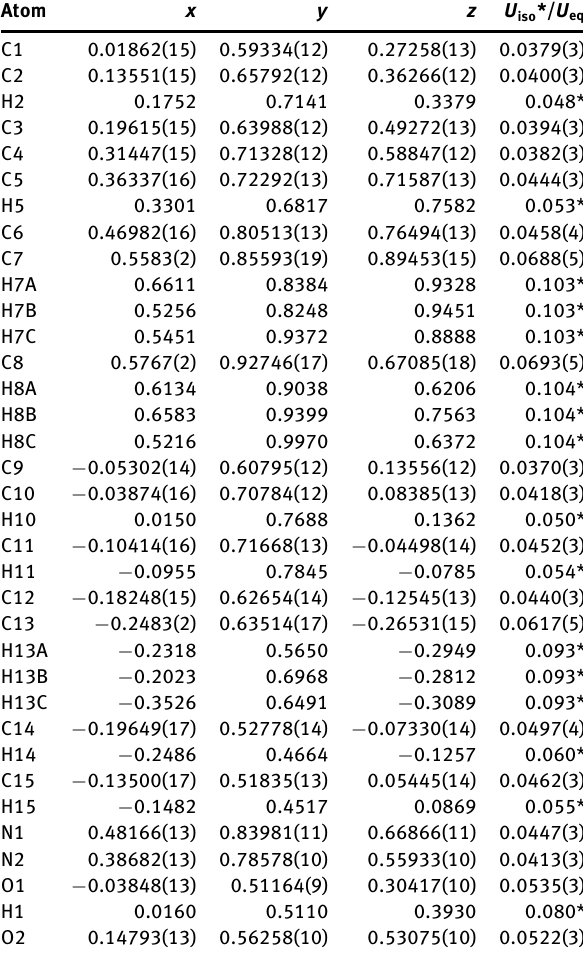
Table 2: Fractional atomic coordinates and isotropic or equivalent isotropic displacement parameters (Å 2 ).